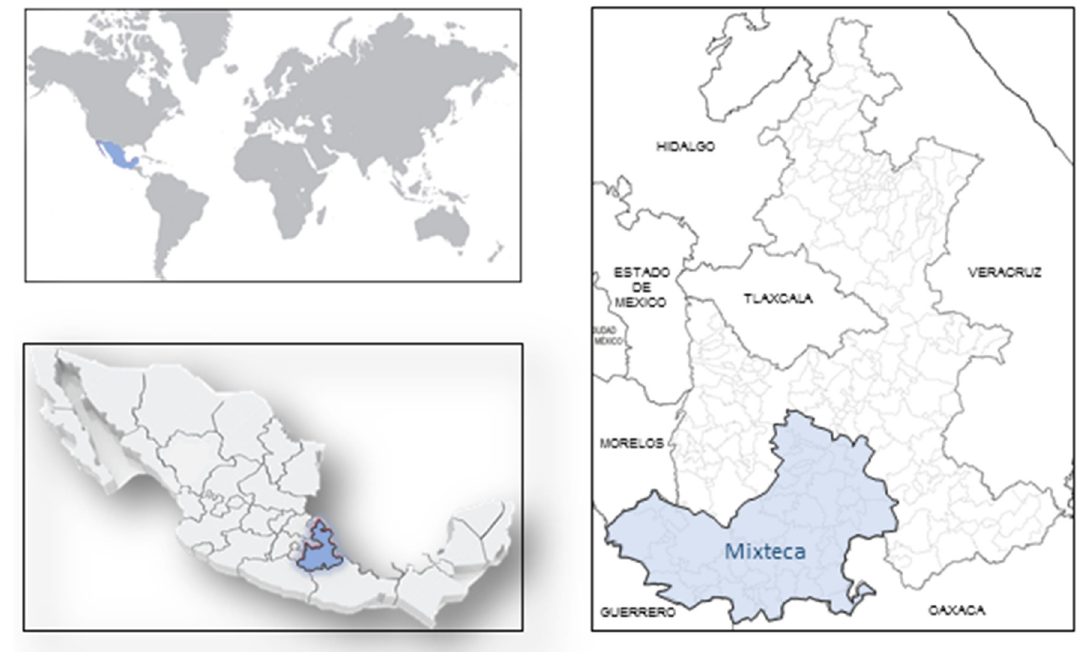
Figure 1. Location of Mixteca region in the state of Puebla,